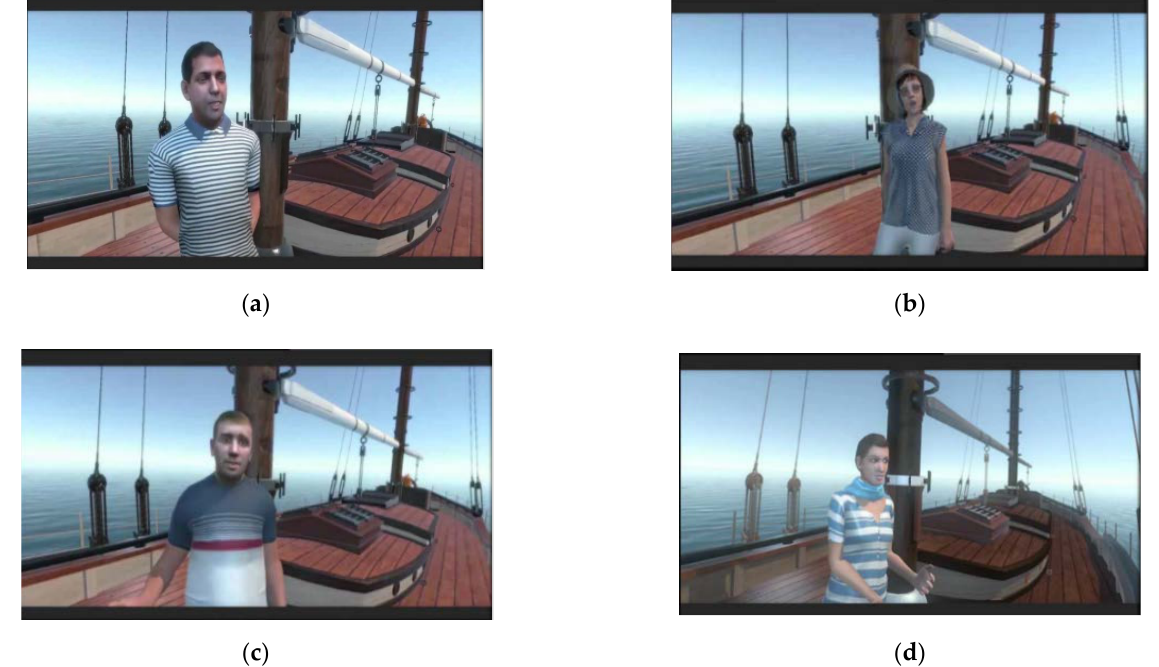
Figure 1. Virtual agent character profiles: ( a ) Expert; ( b ) Organizer; ( c ) Emotional and Communicative Individual; ( d ) Strategist.